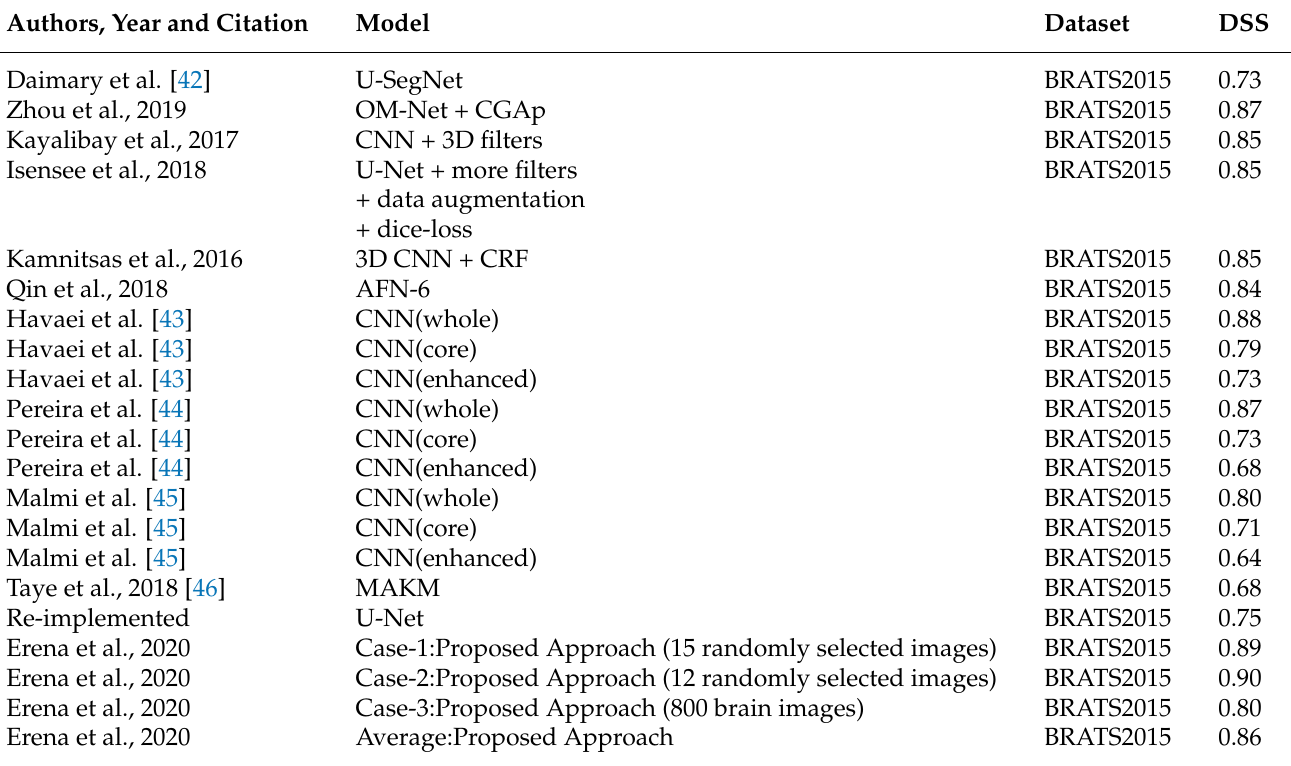
Table 5. Comparison of the proposed approach with U-Net and its variants using BRATS2015